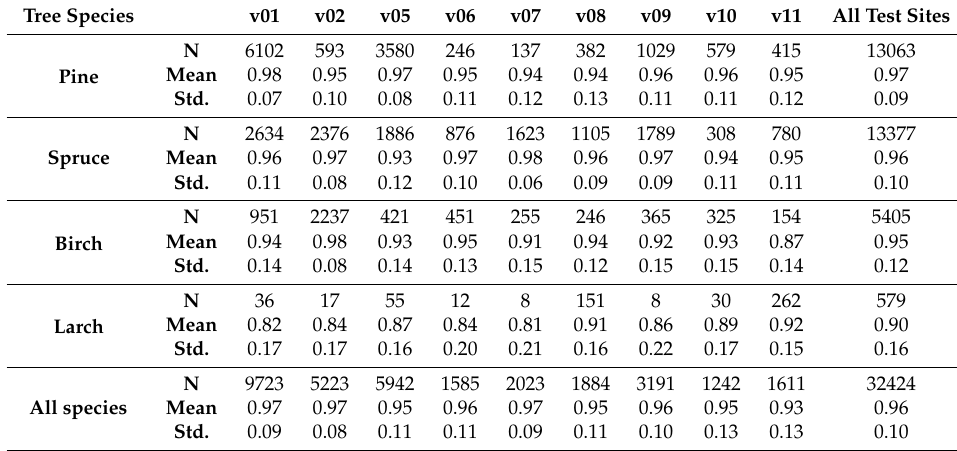
Table 19. Species- and area-specific prediction probabilities using the MLP model trained with a feature-selected data set selected from all features. N indicates the number of trees classified to a specific species at a specific area; Mean is the mean prediction probability; Std. is the standard deviation. Tree Species v01 v02 v05